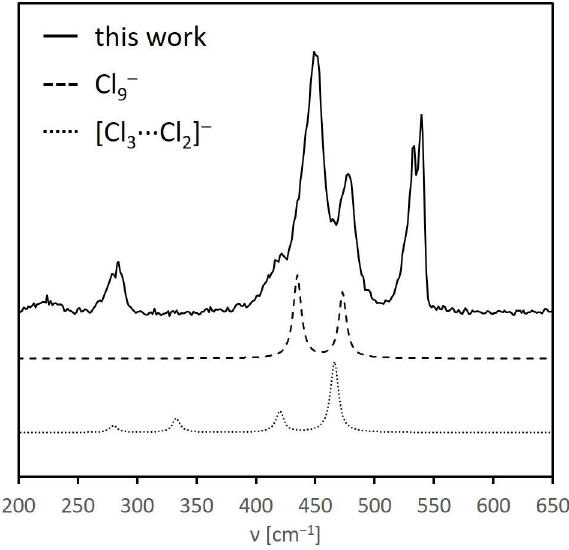
Figure 6. Comparison of the 200–600 cm − 1 region of sample B spectra at 3.9 GPa with Raman bands of polychloride anions derived from ref. [42] for Cl 9– anion and from ref. [43] for 2D polychloride network. Relative intensities are also adapted from cited works.